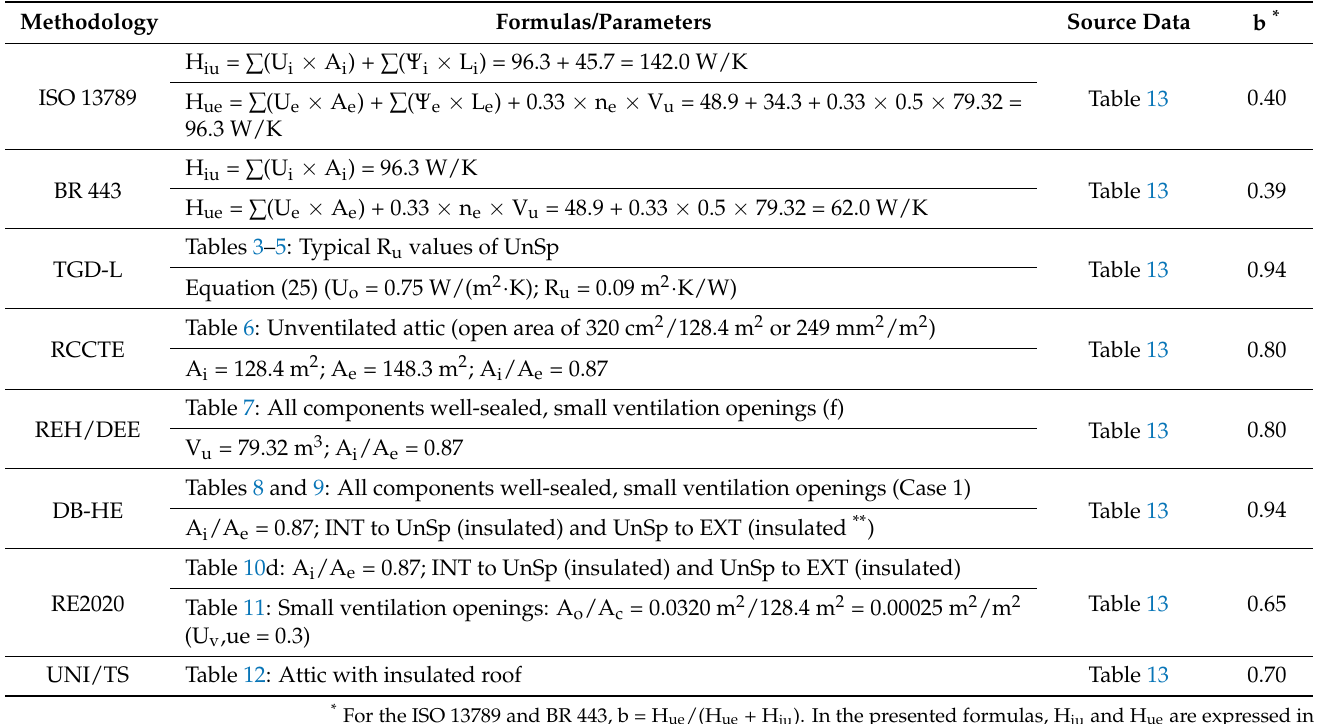
2 /128.4 m 2 = 0.00025 m 2 /m 2 o /A c = 0.0320 m